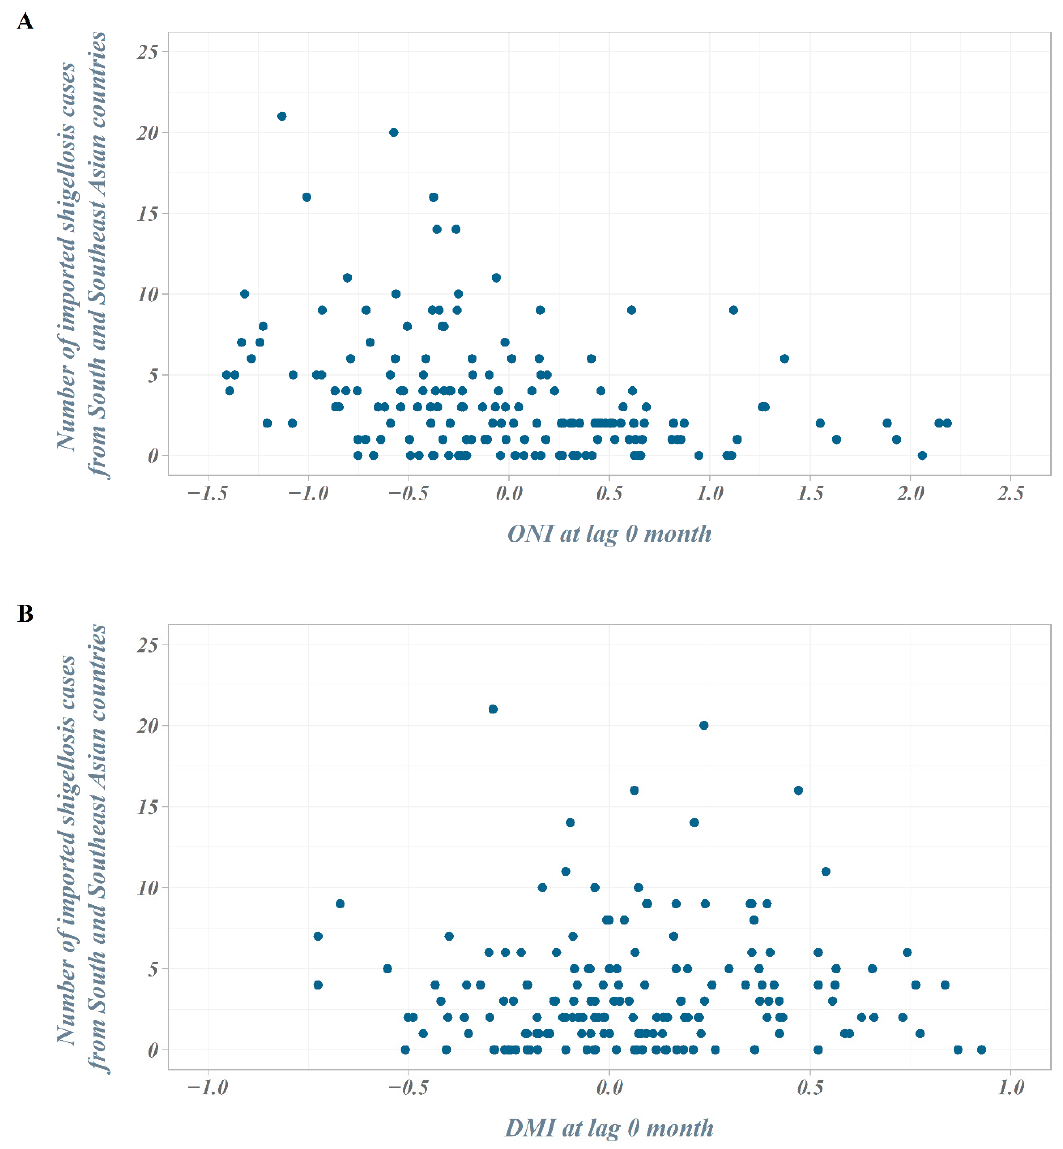
Figure 3. Scatter plot of the number of imported shigellosis cases and climate indices. ( A ) Scatter plot of the number of imported shigellosis cases and ONI at lag 0 month; ( B ) scatter plot of the number of imported shigellosis cases and Dipole Mode Index (DMI) at lag 0 month.